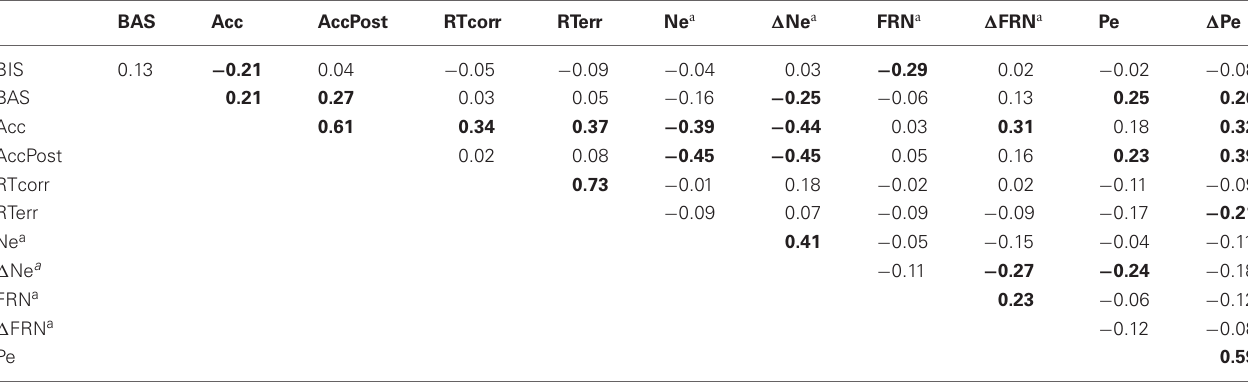
Table 2 | Pearson’s correlations between personality measures, behavioral measures, and ERP components in the deterministic learning condition.